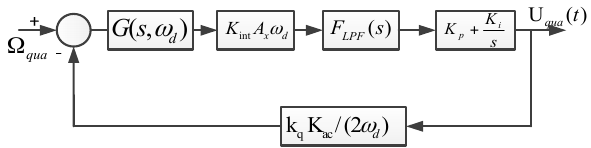
Figure 11. Simplified closed-loop quadrature correction control system.